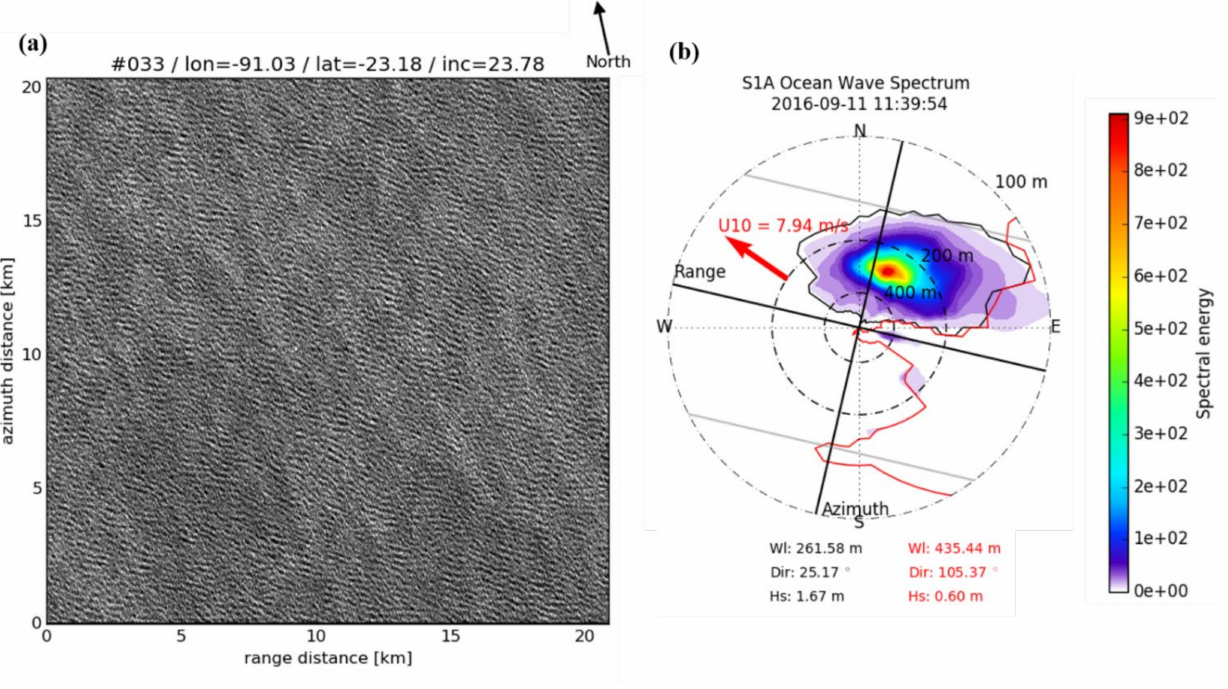
Figure 2. ( a ) Sentinel-1A wave mode roughness image acquired on 11:39:54 UTC 11 September 2016 at 23.18 ◦ S/91.03 ◦ W, and ( b ) corresponding Level-2 ocean swell